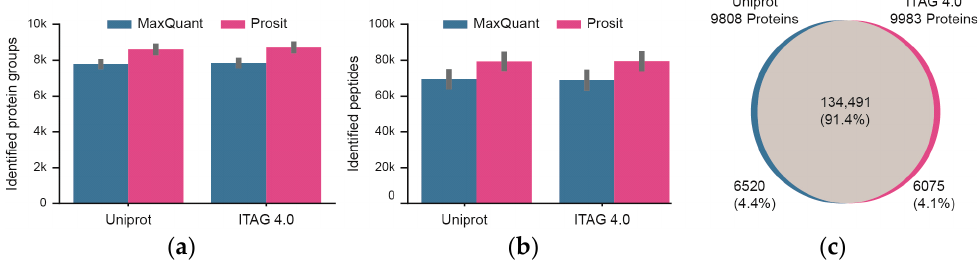
Figure 3. Summary of peptide and protein identifications of technical workflow replicates ( n = 4). ( a ) Identification of proteins when searching the Uniprot or TAG 4.0 sequence databases and either including or excluding re-scoring of MaxQuant results using the artificial intelligence Prosit. Black bars represent one standard deviation. ( b ) Same as panel ( a ) but for peptides. ( c ) Venn diagram showing the overlap of peptides identified from Uniprot or ITAG